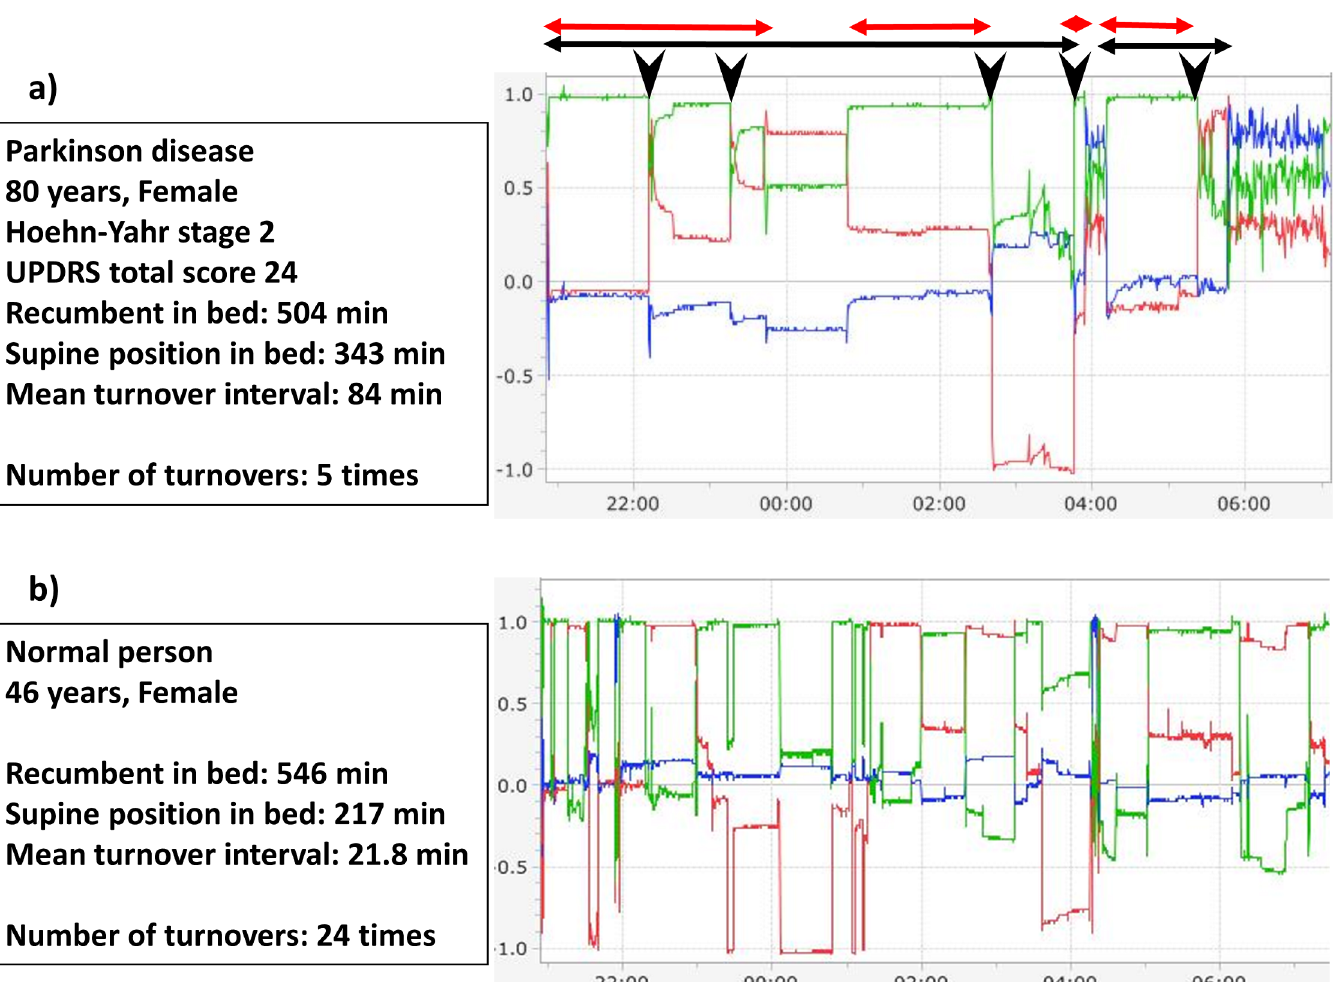
Fig 2. Number of turnover movements in bed in PD patients and healthy subjects. Representative overnightrecordings from 21:00 to 07:00 the followingday are shown. a) Chart from a PD patient. Arrowhead indicatesturnover movement, black lines indicate time recumbent, and red lines indicate time supine. b) Chart from a healthysubject. Variationsin acceleration along the X, Y, and Z axes are represented by red, blue, and green lines,